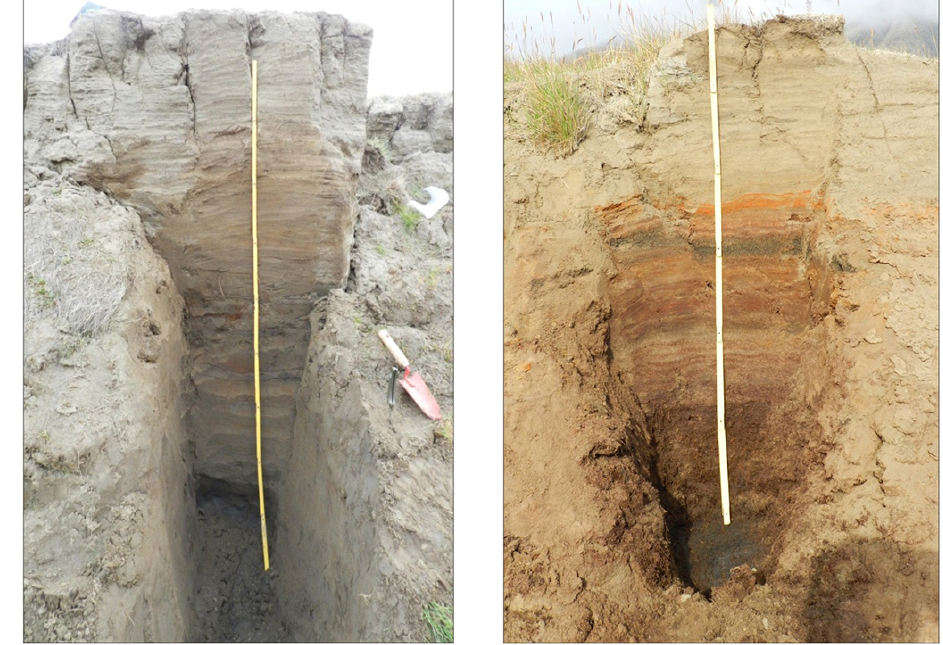
Figure 2. Pictures of the two long sections studied: ADV.20 (left) and ADD.4